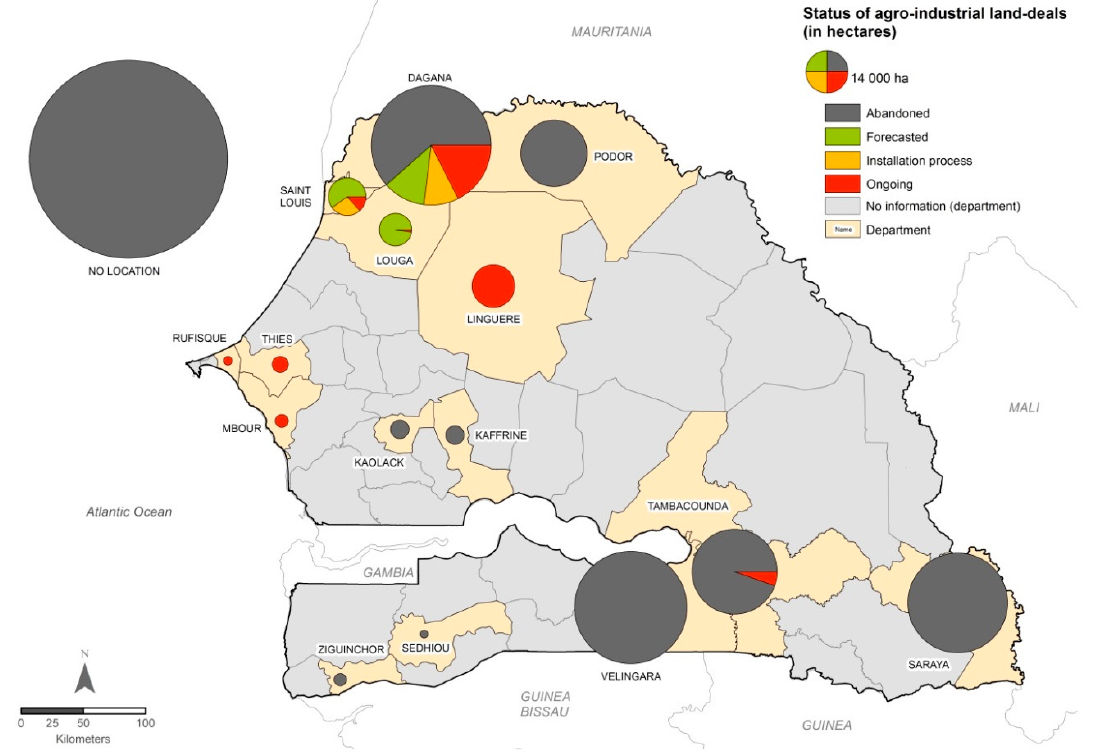
Figure 3. Location and status of agro-industrial land transactions.